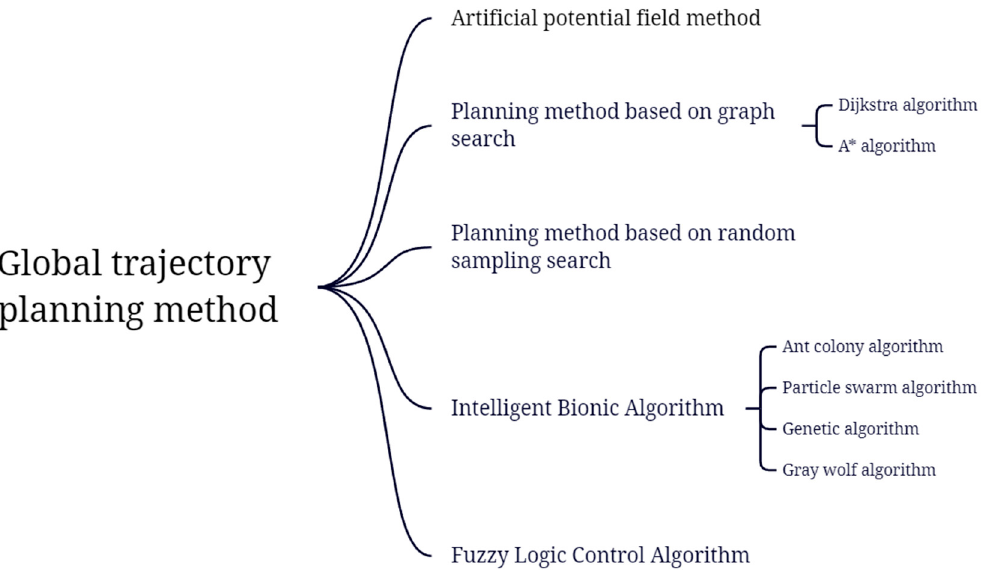
Figure 2. Classification of global trajectory planning methods.